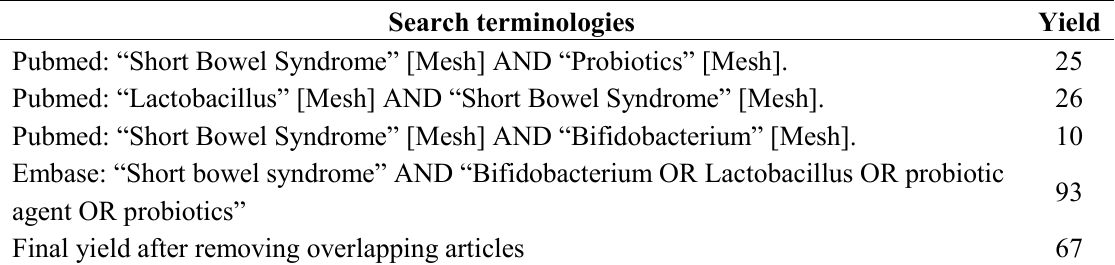
Table 3. Search strategy on Pubmed and Embase.